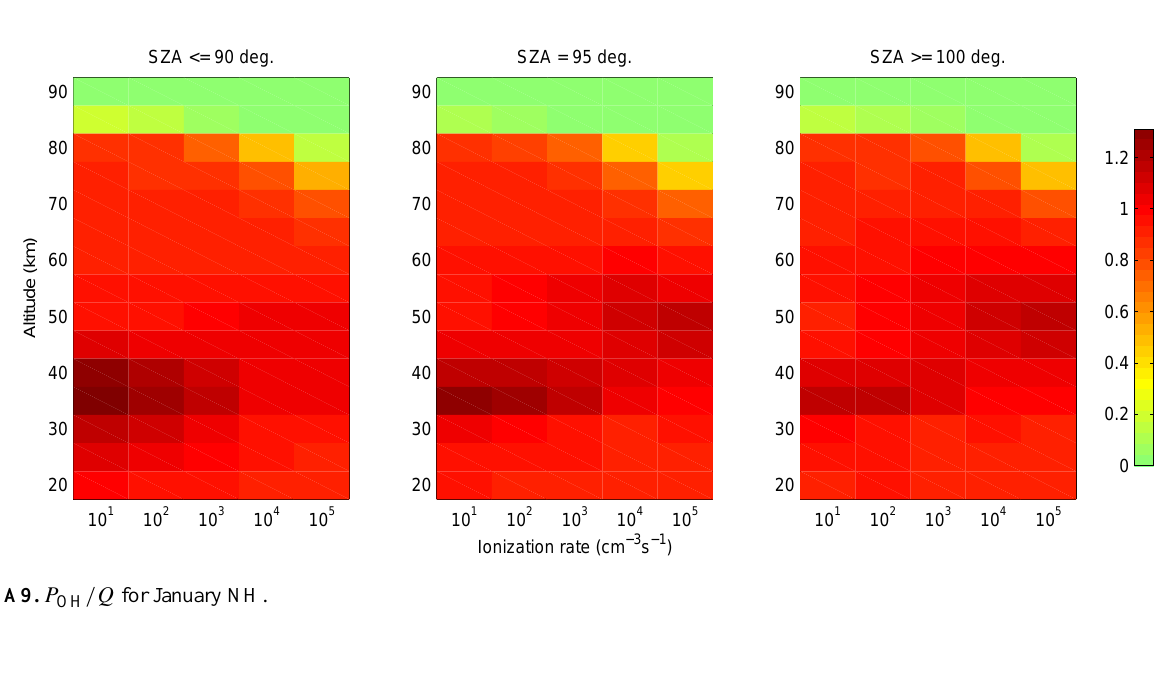
Fig. A9. P OH /Q for January